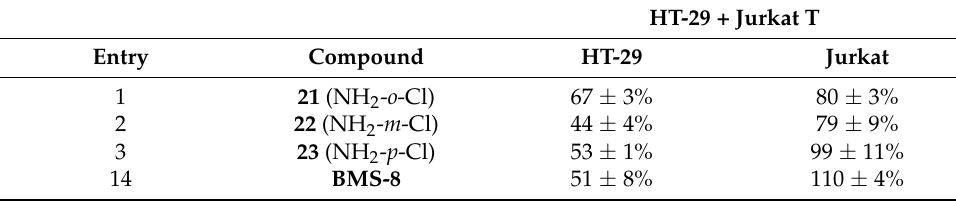
Table 4. Relative number of living cells, in percentage, from both populations from cocultures of HT-29 with Jurkat T cells, respectively, in the presence of compounds 21 – 23 and BMS-8 1